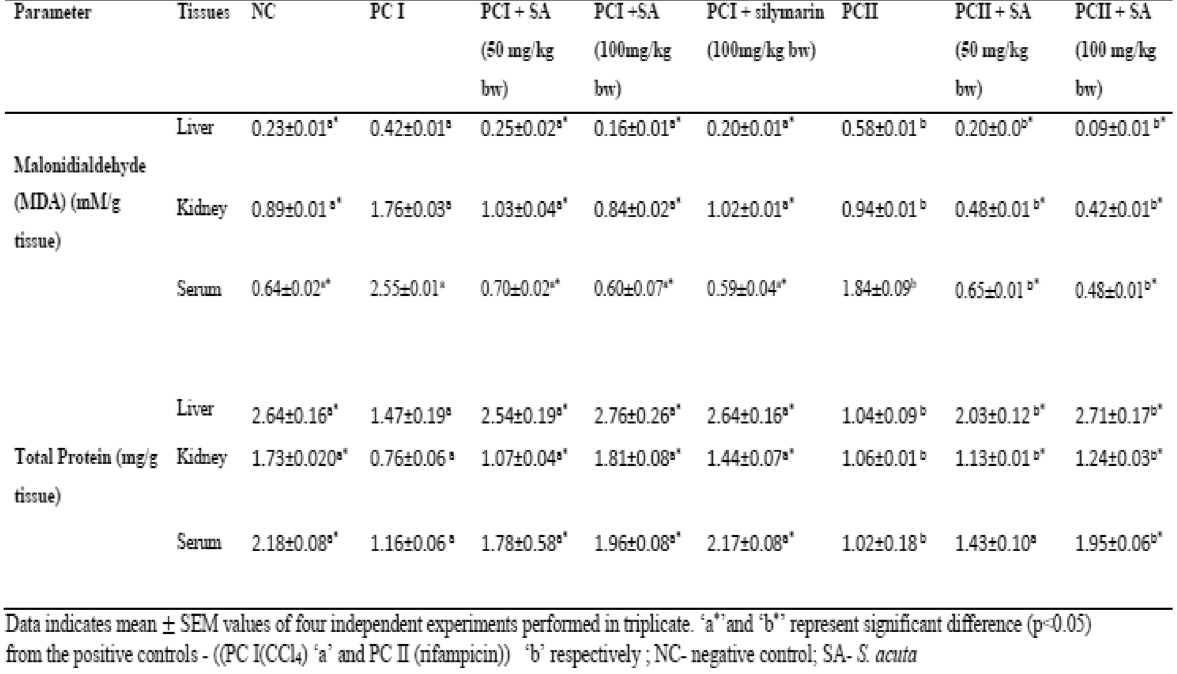
Data indicates mean ± SEM values of four independent experiments performed in triplicate. ‘ a* ’ and ‘ b* ’ represent significant difference ( p <0.05) from the positive controls – ((PC I(CCI4) ‘ a ’ and PC II (rifampicin)) ‘ b ’ respectively; NC- negative control; SA- S.